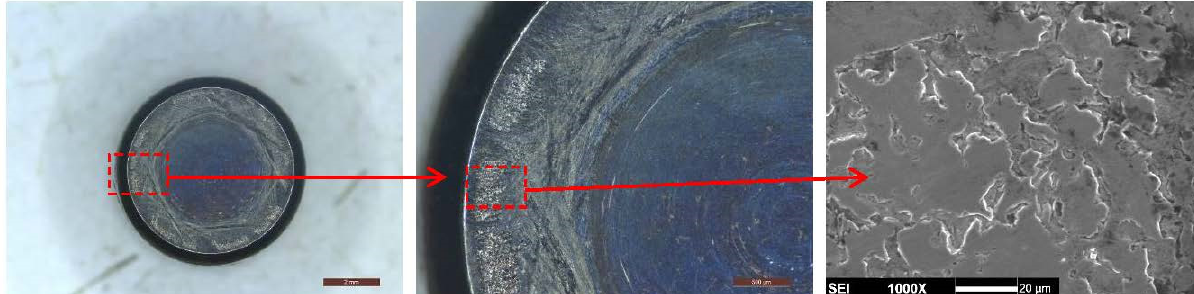
Figure 11. Damages of the roller end face that corresponded to the bearing side with laser marking.